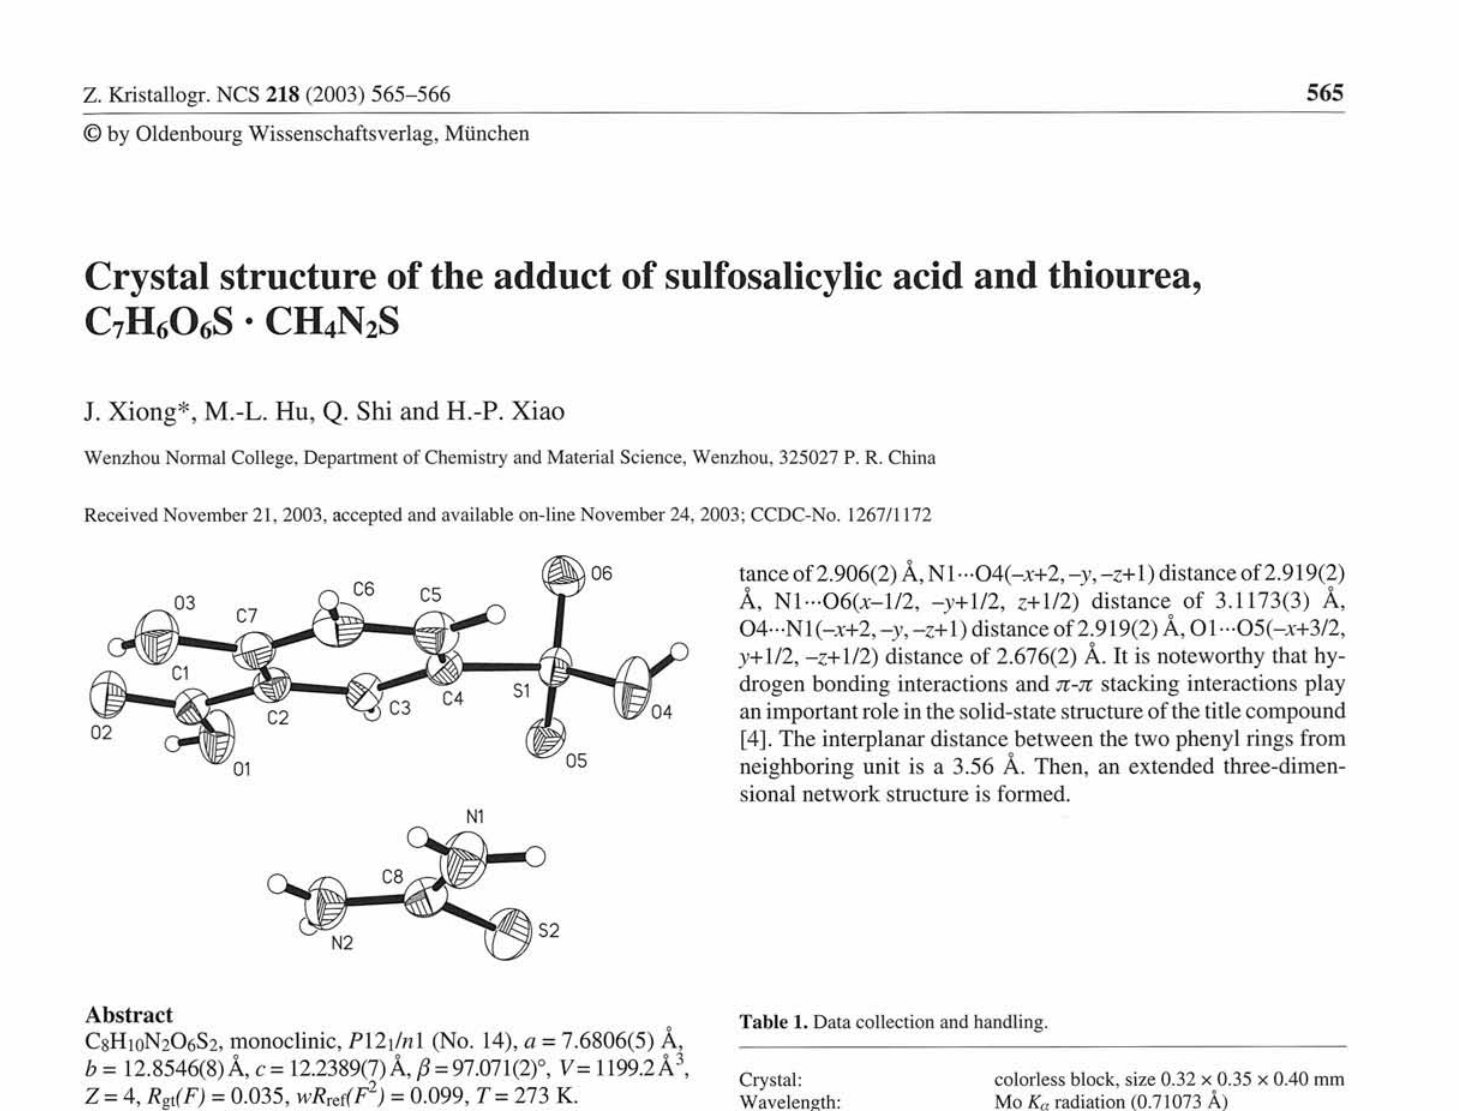
Table 1. Data collection and handling.